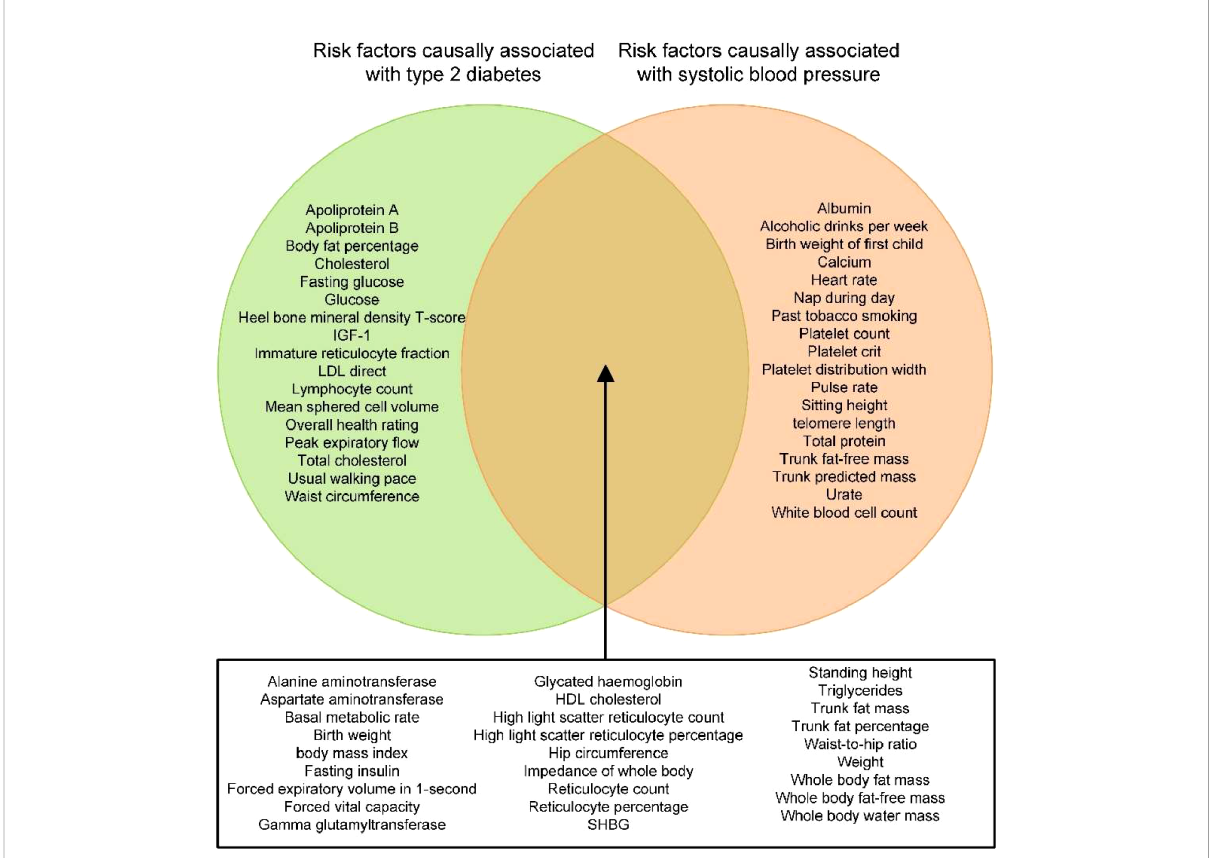
FIGURE 2 Venn diagram depicting the traits that are causally associated with type 2 diabetes mellitus (T2DM) and/or SBP. IGF-1, insulin-like growth factor- 1; HDL, high-density lipoprotein; LDL, low-density lipoprotein; SHBG, sex hormone binding globulin; T2DM, type 2 diabetes mellitus; SBP, systolic blood